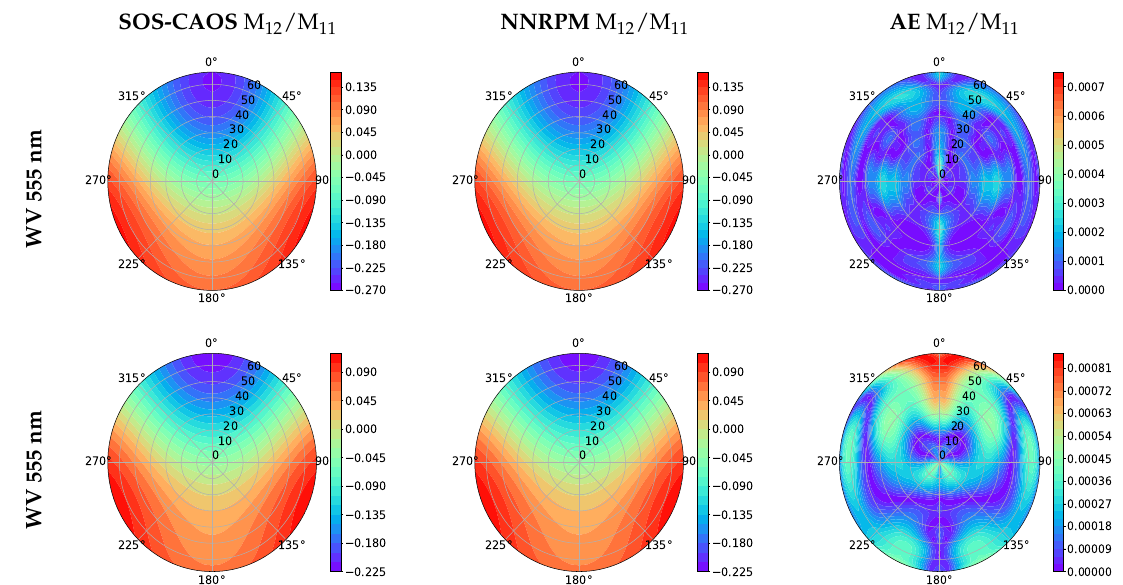
Figure 8. Polar plots of SOS-CAOS, NNRPM and AE for M 12 /M 11 at wavelength 555 nm. Input parameters for Top Row: θ i = 55.91 ◦ , Chla = 20.43 mg/m 3 , a dg ( 440 ) = 0.258 m − 1 , b bp = 0.088 m − 1 , B p = 0.016, S Bp = − 0.157 nm − 1 , S bp = 0.258 nm − 1 , S dg = 0.019 nm − 1 . Input parameters for Bottom Row: θ i = 43.02 ◦ , Chla = 24.77 mg/m 3 , a dg ( 440 ) = 0.0004m − 1 , b bp = 0.098 m − 1 , B p = 0.048, S Bp = − 0.106 nm − 1 ,